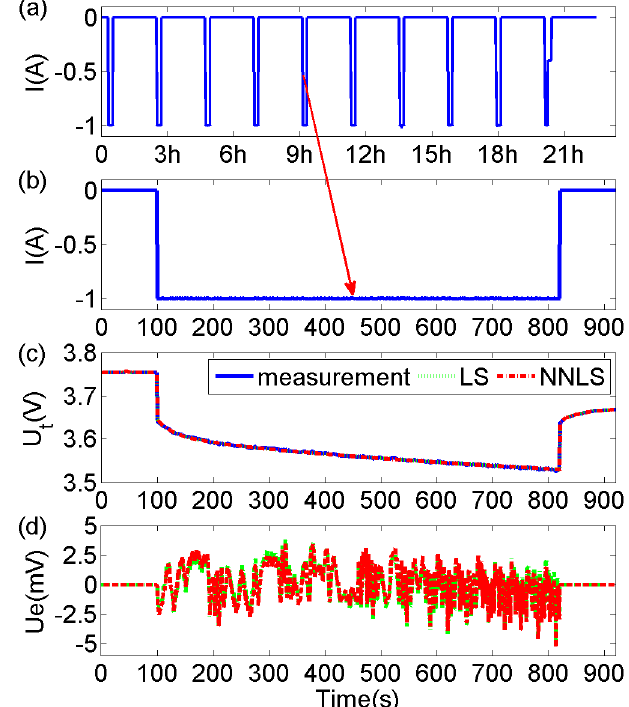
Figure 3. Battery voltage and voltage errors of the three-RC-pair circuit model from SOC = 60% to 50%: ( a ) a current pulse series: the unit for the x -axis is hours; ( b ) current; ( c ) voltage; ( d ) voltage